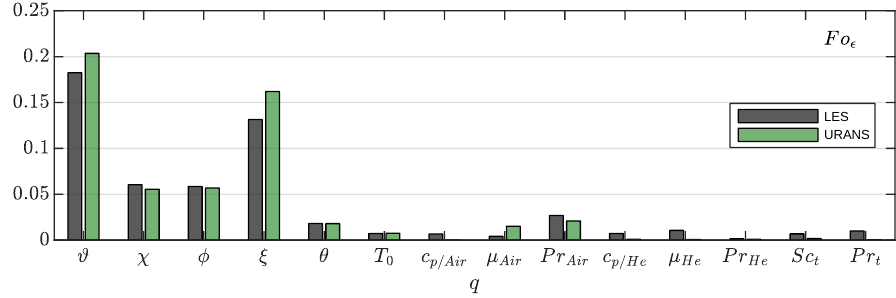
Figure 8. Normalized modified mean µ ∗